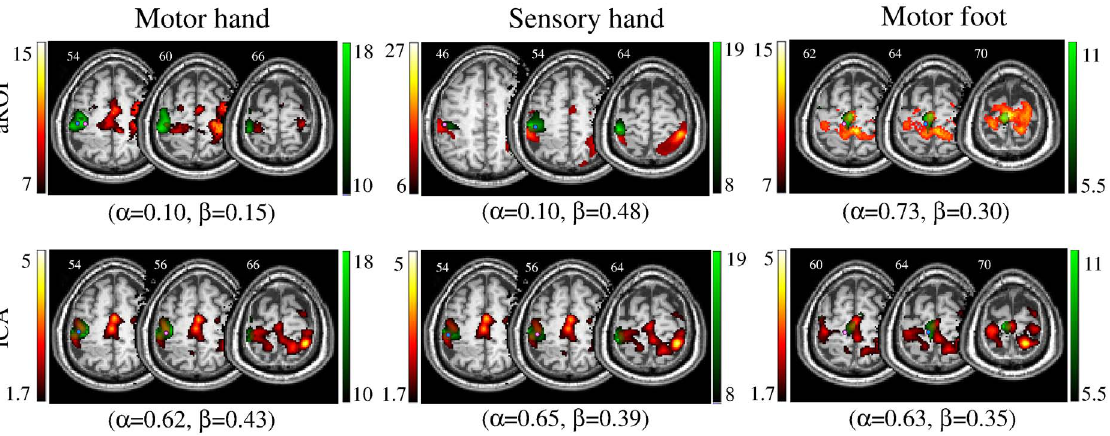
Figure 3. Concordance between task-based (tb-fMRI, in green) and resting-state (rs-fMRI, in red) fMRI maps computed with aROI (top row) and ICA (bottom row). Overlap sensitivity ( a ) and specificity ( b ) of rs-fMRI with respect to tb-fMRI, obtained with operator-dependent thresholds, are reported. Light blue circle represents the Centre of Mass (CoM) of tb-fMRI, and pink circle represents the CoM of rs-fMRI. Images are shown in neurological convention (left is left) and MNI coordinates are reported on top of each slice. For Case 7, ICA showed better overlap values for the motor and the sensory hand area, while aROI showed better overlap values for the foot area. The CoM distance task-ICA was the shortest ( , 7 mm) for the hand and CoM distance task-aROI was the shortest ( , 4 mm) for the foot. doi:10.1371/journal.pone.0098860.g003 activation volumes in comparison to tb-fMRI for hand and mouth Based on the AMPLE criterion (Table 5), overlap sensitivity tasks, but only a very small number of voxels on ICA maps and specificity were similar to those obtained with the intersected with the foot area. operator-dependent method. The sensitivity was a , 0.40 and